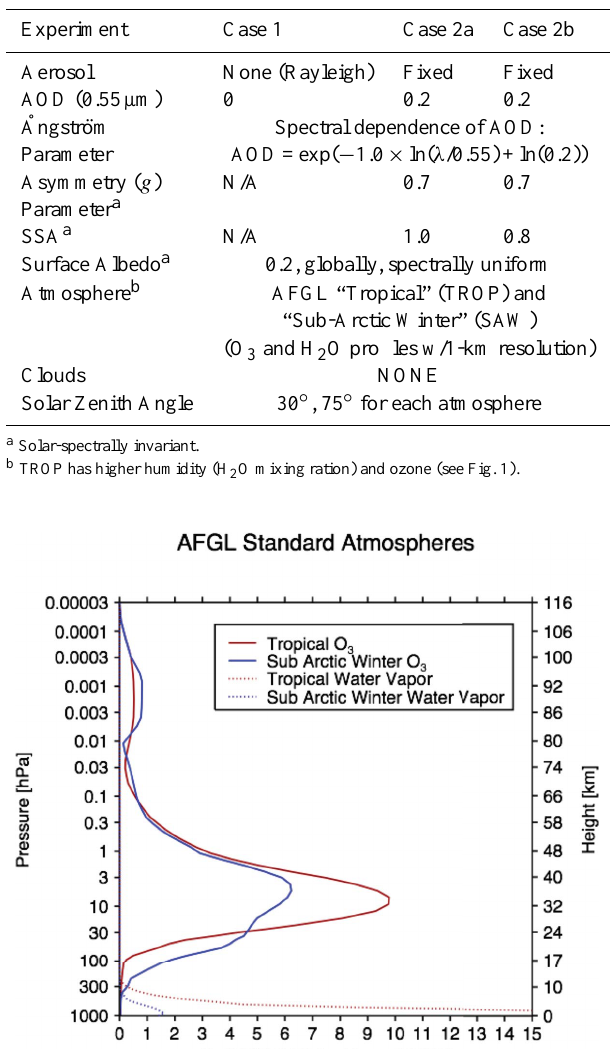
Table 2. Protocol summary.